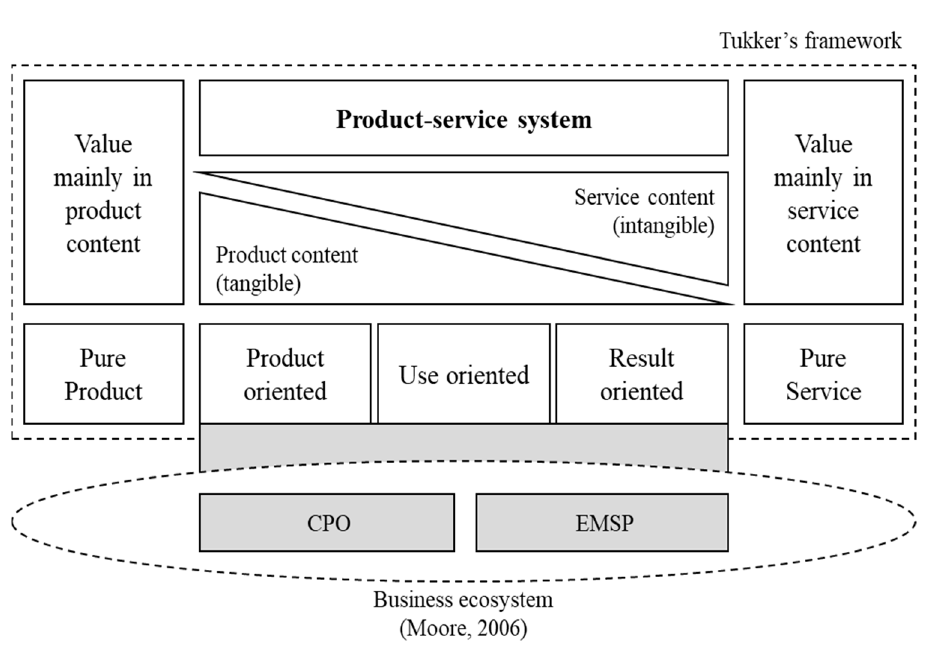
Figure 2. Classification of EV charging according to Moore and Tukker (own diagram based on [15,16]).